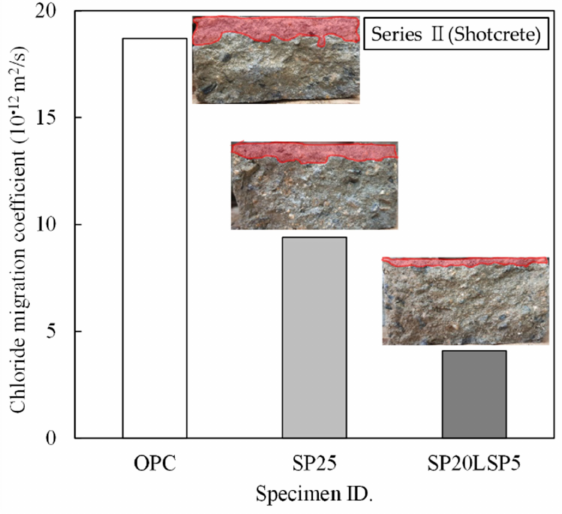
Figure 8. Chloride migration coefficient of shotcrete.